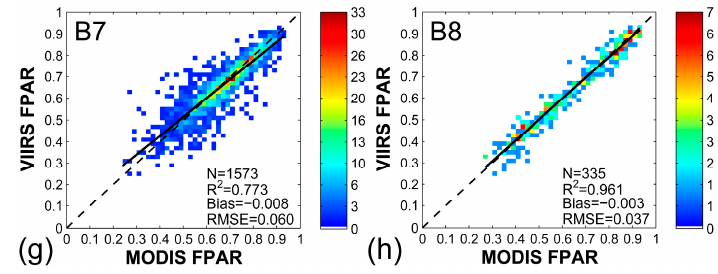
Figure 5. The ( a – h ) stands for biome 1–8, respectively. The eight biomes are (B1) grasses and cereal crops, (B2) shrubs, (B3) broadleaf crops, (B4) savannas, (B5) evergreen broadleaf forest, (B6) deciduous broadleaf forest, (B7) evergreen needleleaf forest, (B8) deciduous needleleaf forest.